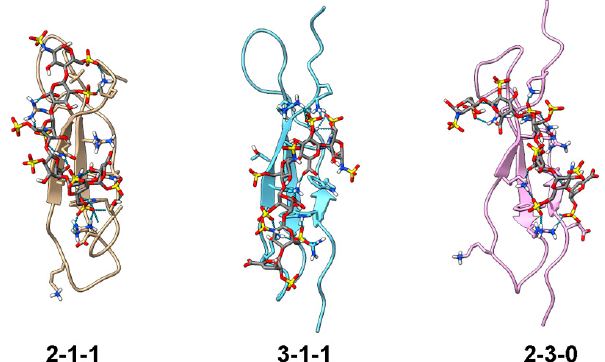
Figure 6. Top three models of CTD docked with DP6-C. CTD is shown in the ribbon representation. DP6-C and side chains of amino acids near DP6-C are shown in stick representations. Hydrogen bonds and electrostatic contacts between CTD and DP6-C are shown as dotted cyan lines. Models were created by docking DP6-C onto CTD using distance constraints between 2-O-sulfate groups and residues known to contact uronate protons. This was followed by simulation without distance constraints. The models were then ranked based on the calculated binding energy and distances between PTN residues and DP6-C protons known to have intermolecular contacts in the 15 N-edited NOESYHSQC. For docked NTD structures, the shortest distances between W18.H ε 1, W20.H ε 1, R52.H ε ,